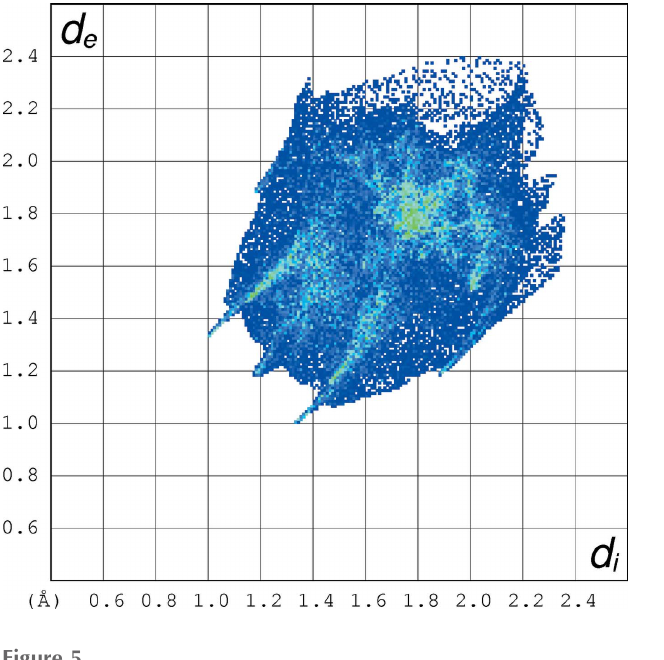
Figure 5 Hirshfeld fingerprint plot for